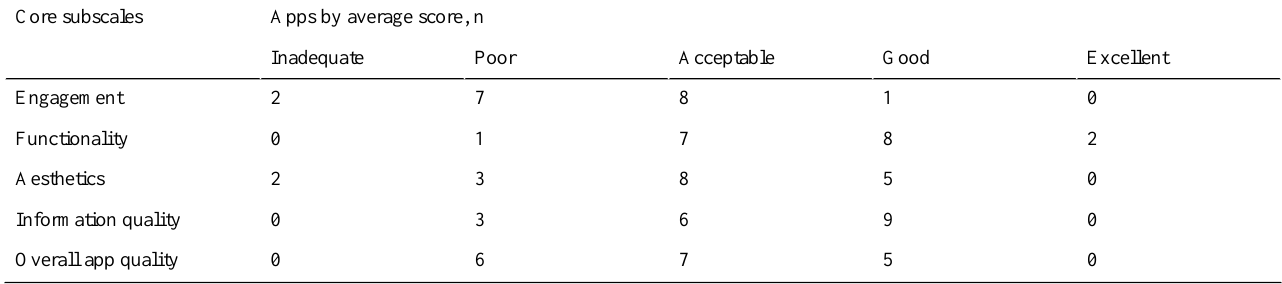
Table 4. Mobile App Rating Scale average scores.